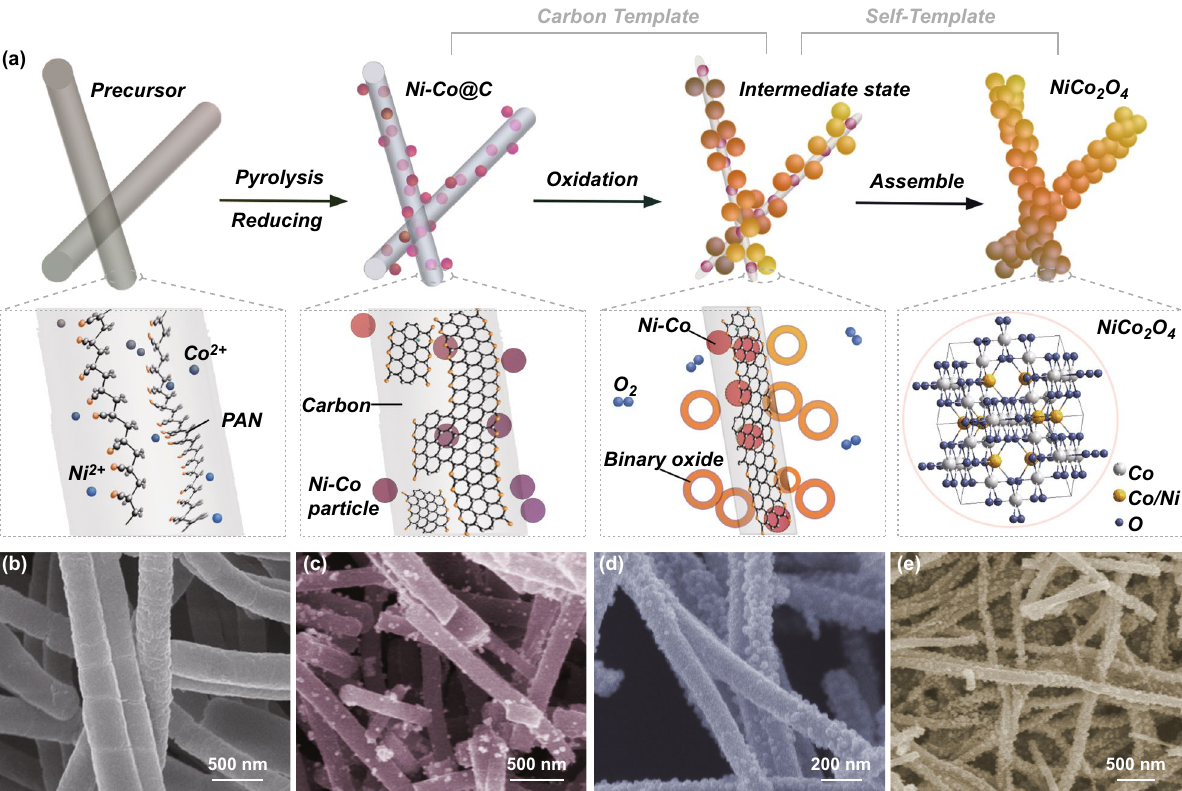
Fig. 1 a Growth process for NiCo 2 O 4 , and the corresponding cross‑sectional view with different molecular structure. b‑e SEM images corre‑ sponding to each growth